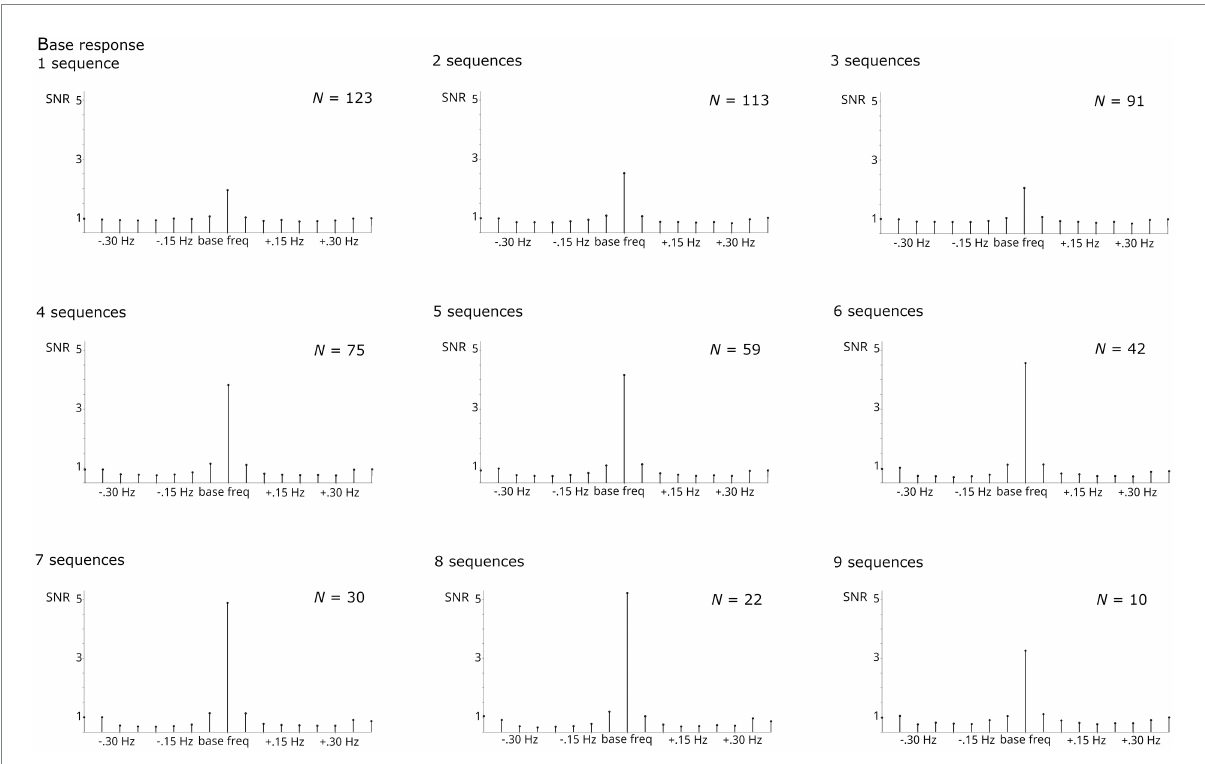
FIGURE 4 SNR of grand-average base responses summed across harmonics 1–5 and compared across numbers of sequences averaged. The respective N contributing to each analysis is specified per graph. Highly significant base responses were obtained in all